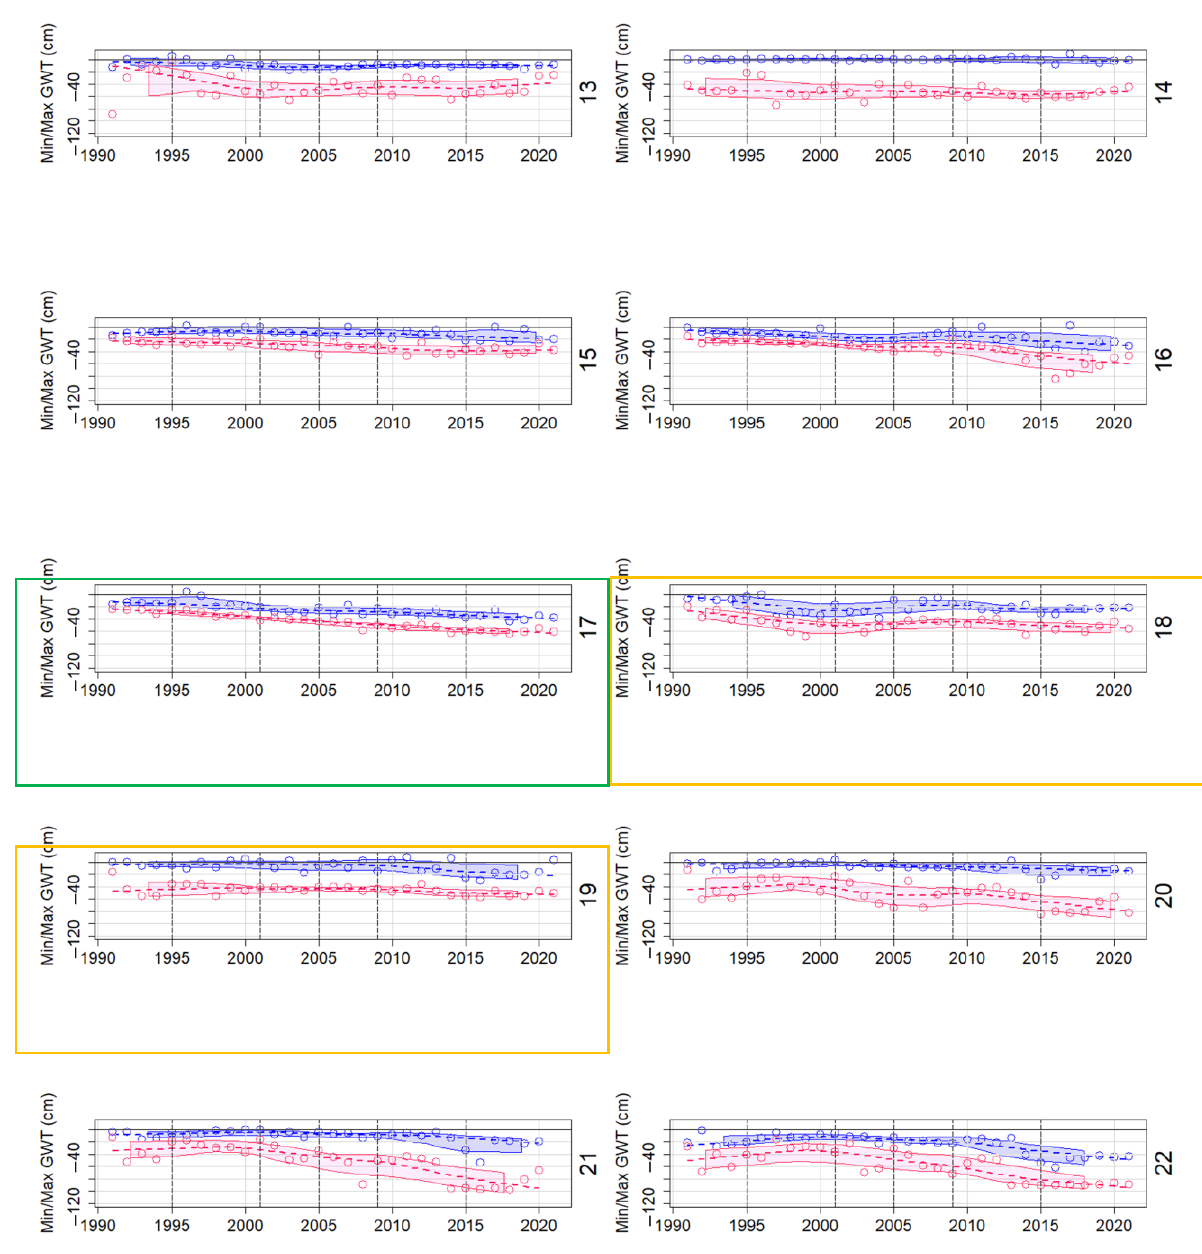
Figure 12. The minimum (red) and maximum (blue) ground water levels of individual probes from lower to higher altitudes (probe 1 to 22) in individual years (x-axis) and smoothing by loess with spread intervals (span = 50). Green-framed charts exemplifying probes 10 and 17 are placed directly below the ditches; yellow framed probes 11, 12 and 18, 19 are next to the melioration ditches from above. Black horizontal line represents ground surface. The dashed vertical lines show the break years of the double mass curve (see Figure 8).